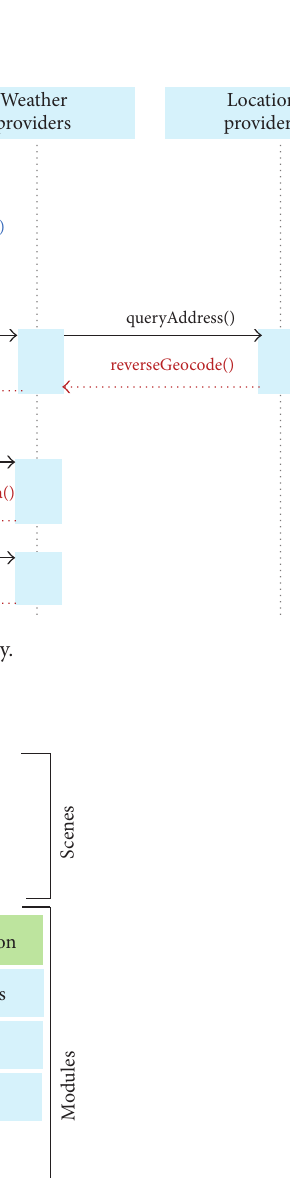
“Gardening tools” in easy to reach area